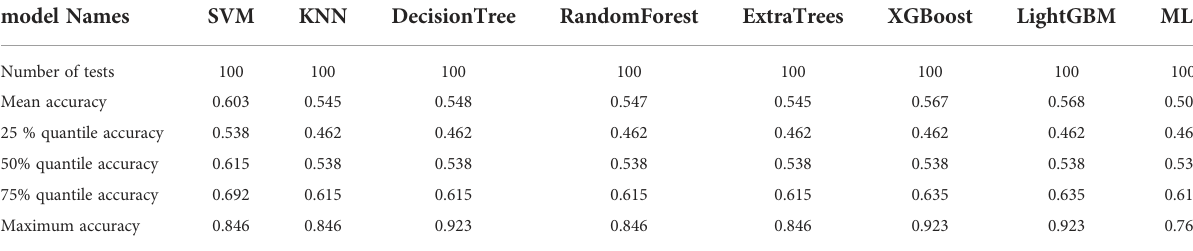
TABLE 13 Distribution of the accuracy of each model randomly tested 100 times by eight common machine learning